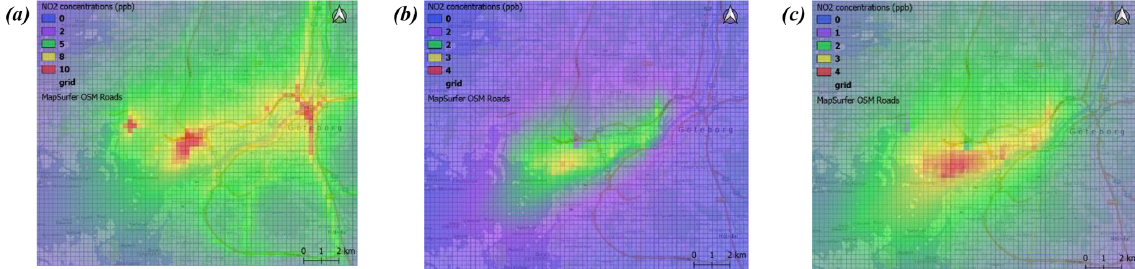
Figure 7. Simulated atmospheric concentrations of NO 2 (in ppb) for the year 2012: (a) annual mean concentrations in the base case sim- ulation, (b) annual mean contribution of local shipping and (c) annual mean contribution of local and regional shipping. Base map